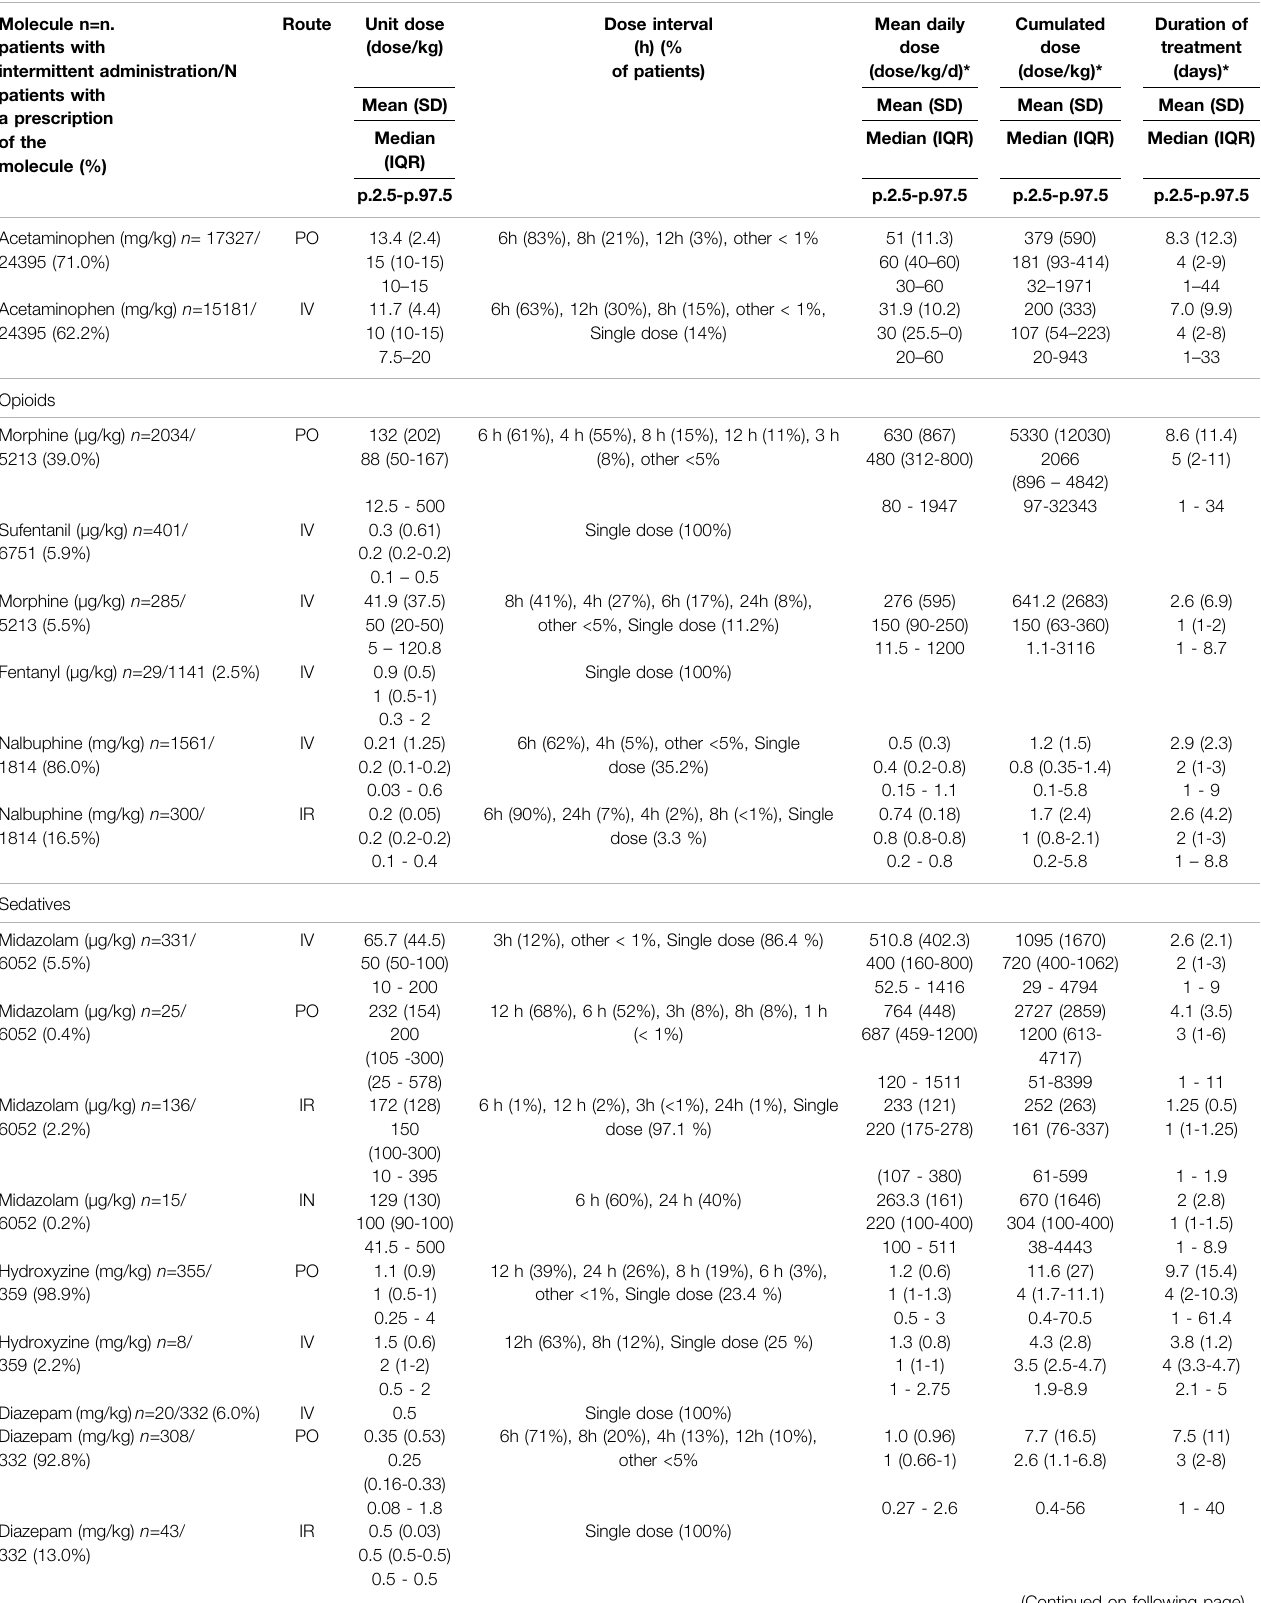
TABLE 4 | Description of doses and duration of treatment for drugs prescribed as single doses or intermittent administration Molecule n=n. patients